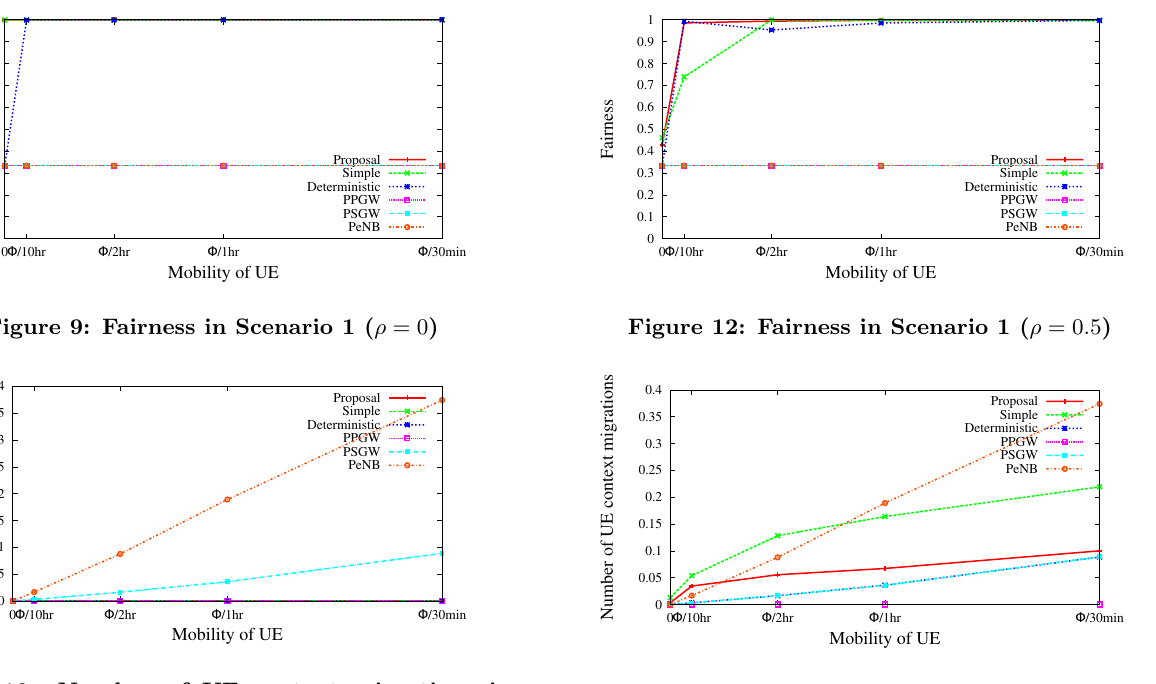
Figure 13: Number of UE context migrations in Scenario 1 ( ρ = 0 . 5